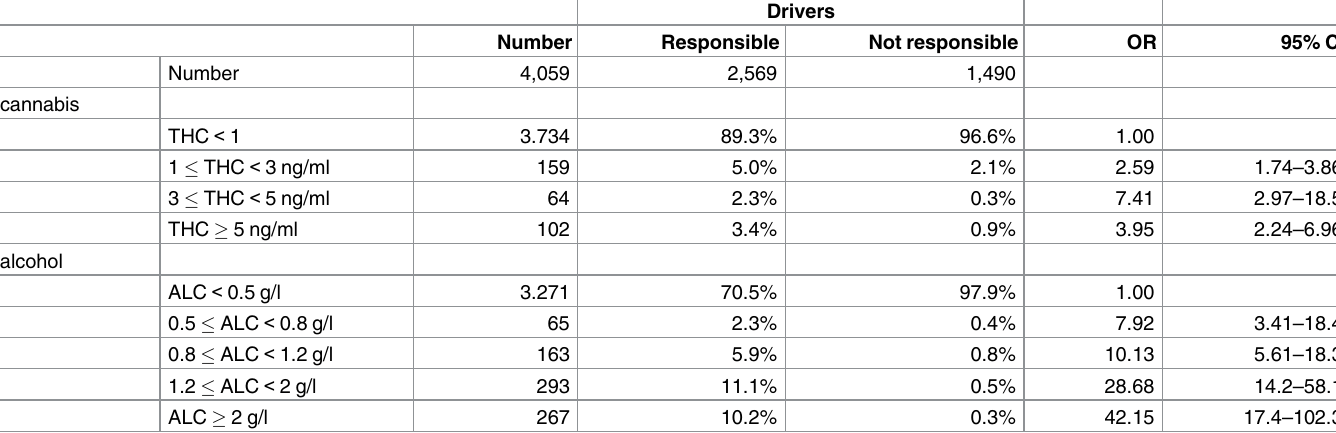
Table 2. Prevalence and crude OR of responsibility linked to driving under the influence of alcohol and cannabis per detected dose (n = 4,059 driv- ers involved in a fatal accident, source Voiesur 2011